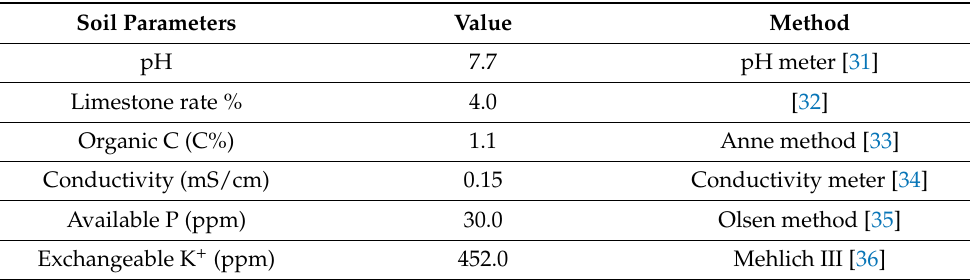
Table 1. Soil characteristics before the experiment setup (0–30 cm).